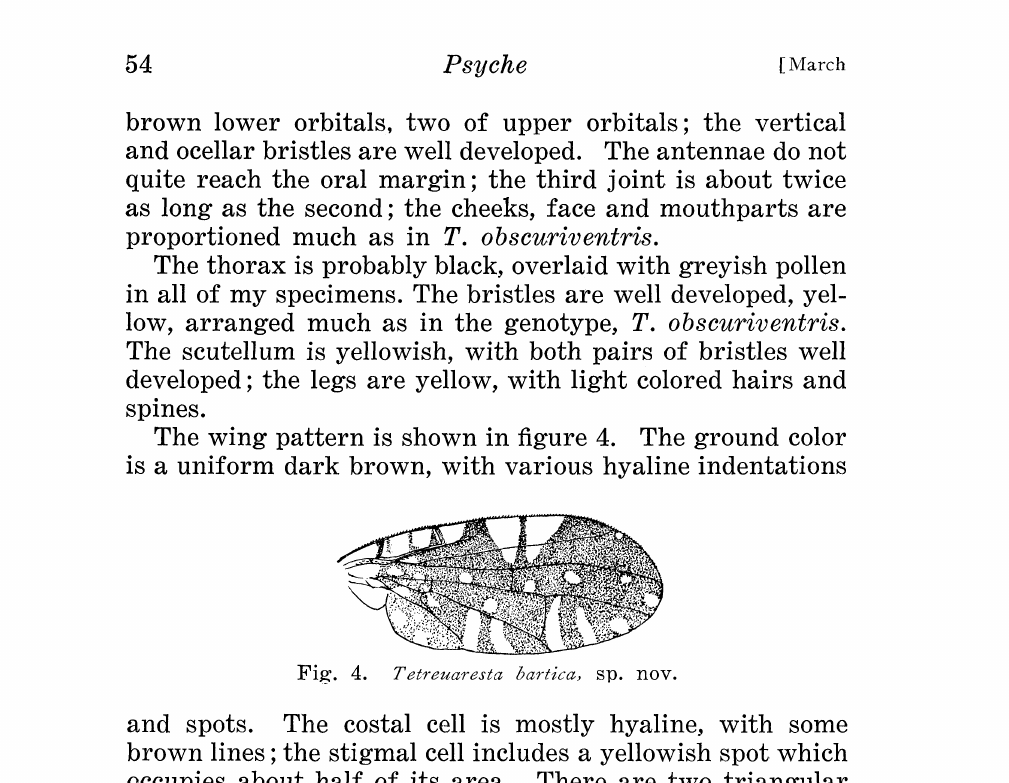
Fig. 4. Tetrena’esta Darticc, SD.